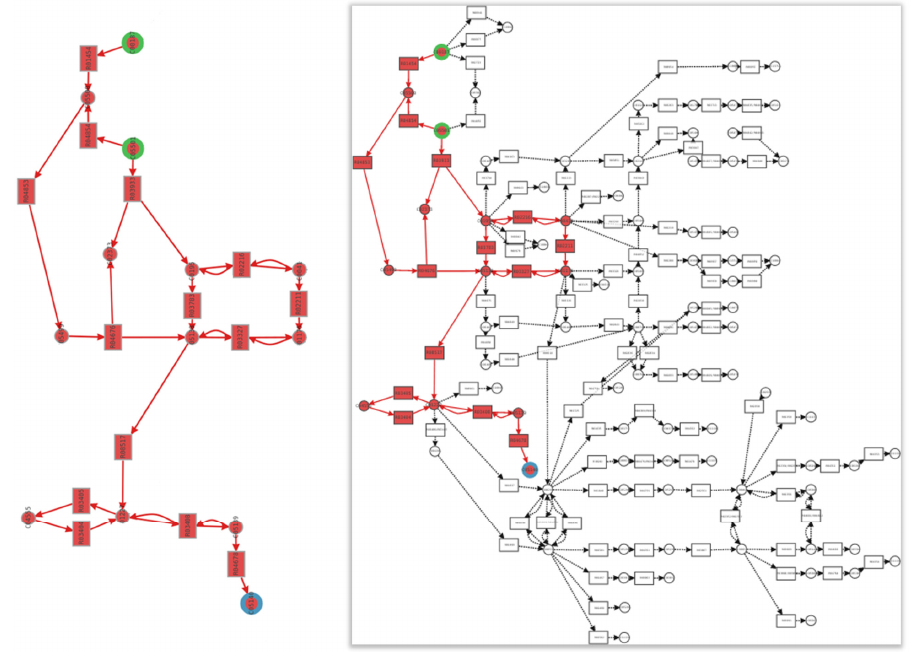
Figure 3. Example of a sub-pathway. The production sub-pathway of 4-Androsten-16alpha-ol- 3,17-dione (blue node) starting from cholesterol and 20alpha,22beta-Dihydroxycholesterol (green nodes). This sub-pathway ( left ) was dissected from the steroid hormone biosynthesis pathway ( right ). The circles, rectangles and arrows are representing metabolites, metabolic reactions and reaction reversibility, respectively.